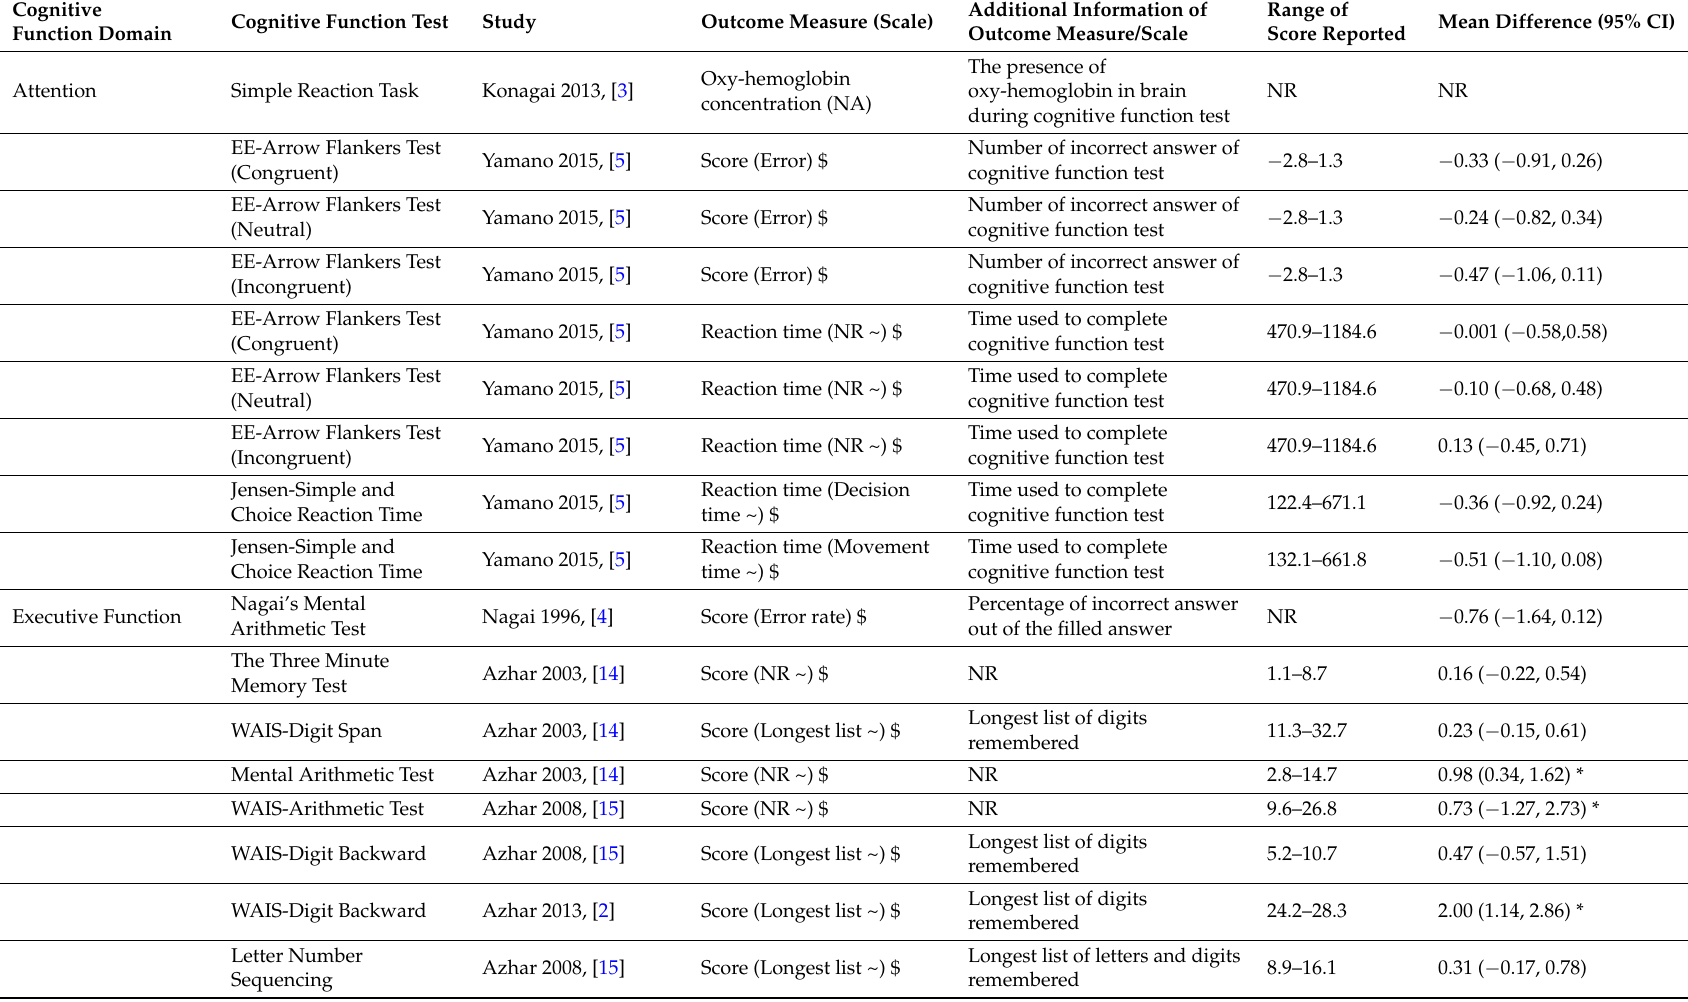
Table 4. Characteristics of cognitive function